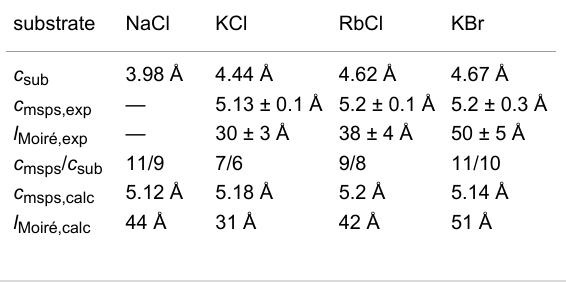
Table 1: Experimental and calculated MSPS lattice constants c msps and Moiré pattern distances l Moiré . For the calculated values a 2-D coincidence is assumed for ( n − x ) MSPS/ n ionic distances; x = 1 or